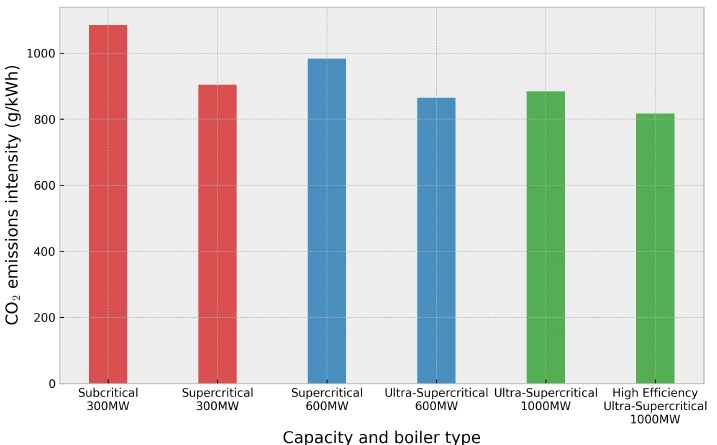
Figure 4. Emission intensity for different boiler